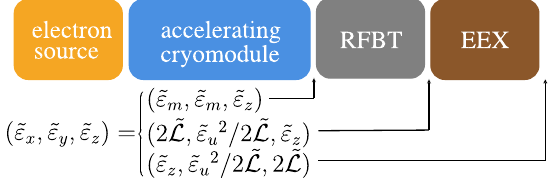
FIG. 1. Block diagram of the proposed damping-ring-free injector concept. The emittance partitions at the various stages along the injector are also listed. We defined ˜ ε m ≡ ½ ˜ ε 2 u þ See text for